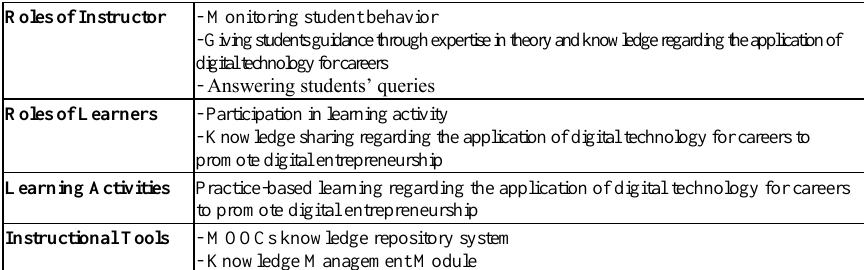
Table 5. Knowledge Sharing